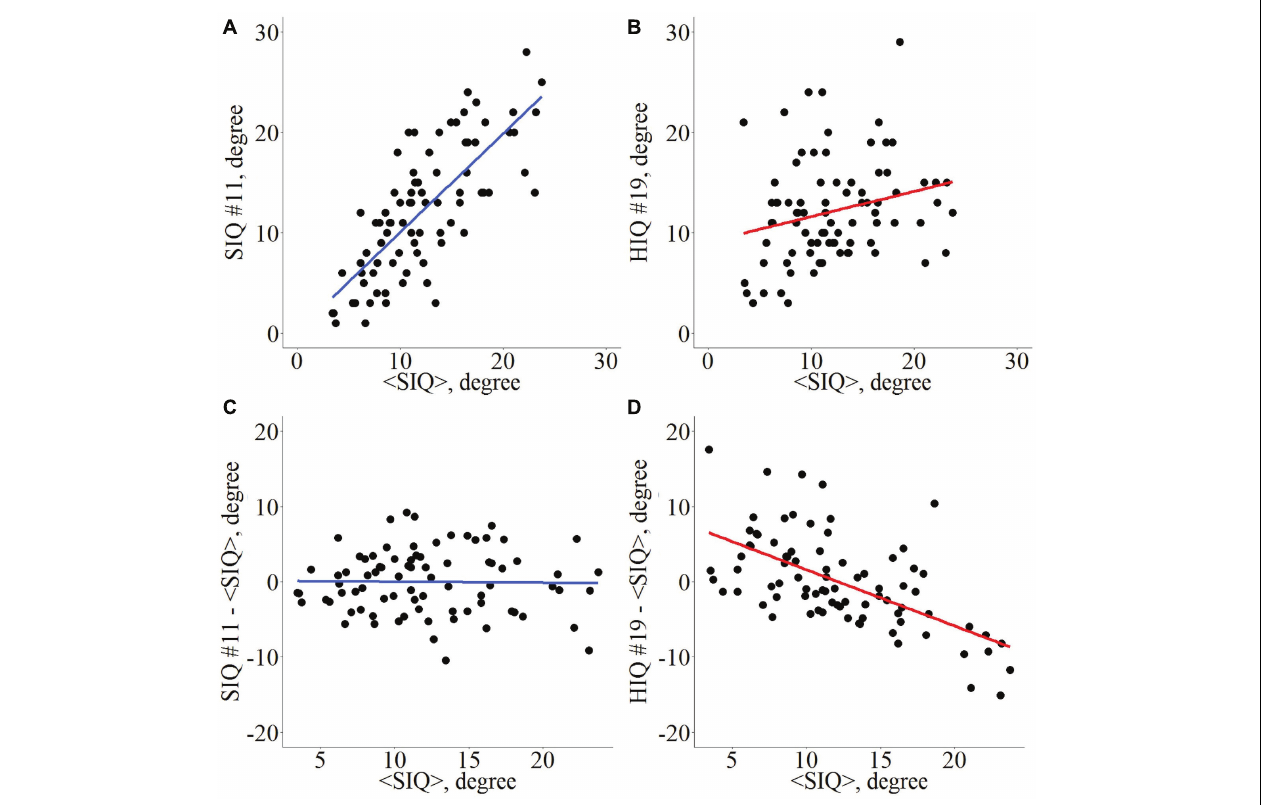
FIGURE 1 | Hub disruption index κ computation for a graph metric. Given a set of nodes from an atlas N i , i ∈ [1, n ], and a nodal metric M , each node i presents a value M i , i ∈ [1, n ] for a given subject. Across a set of reference subjects R j , j ∈ [1, m ], the averaged nodal metric can be computed < M i > R . For each individual I k , k ∈ [1, p ], whatever its status (patient, HIQ child, or healthy subject), its metric in each node is M i , I and the difference in nodal metric with the reference group is M i , I k